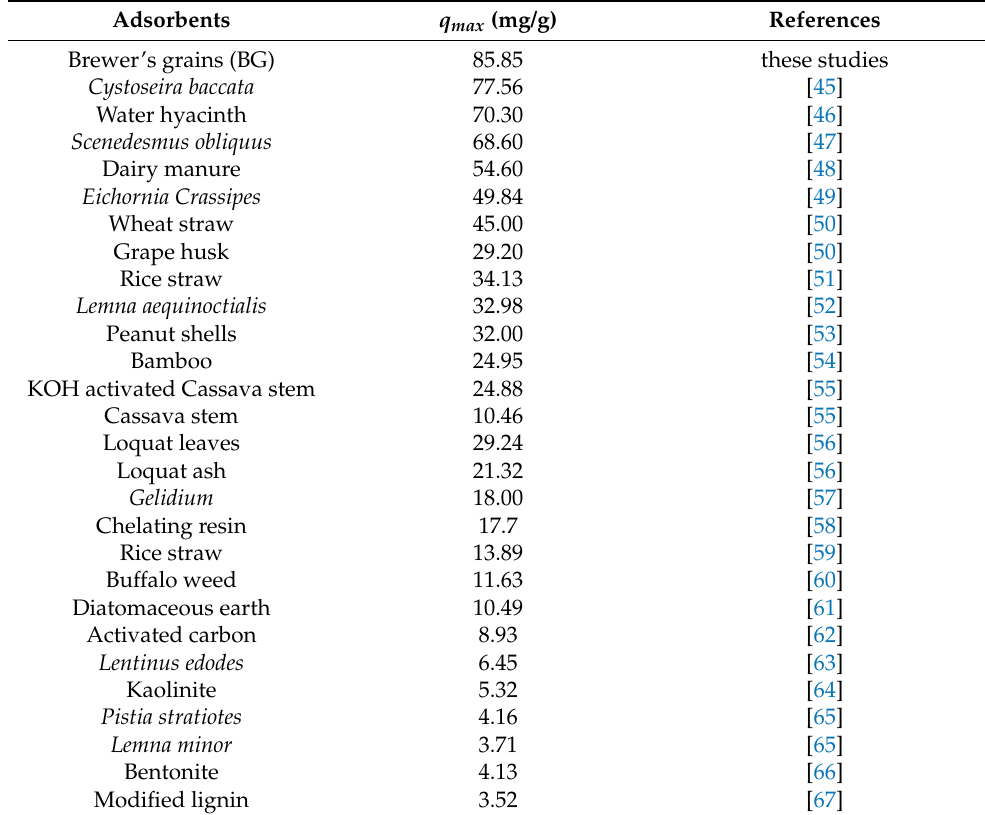
Table 5. A comparison of biosorption capacity of BG for the removal of Cd(II) ions with different adsorbents in the